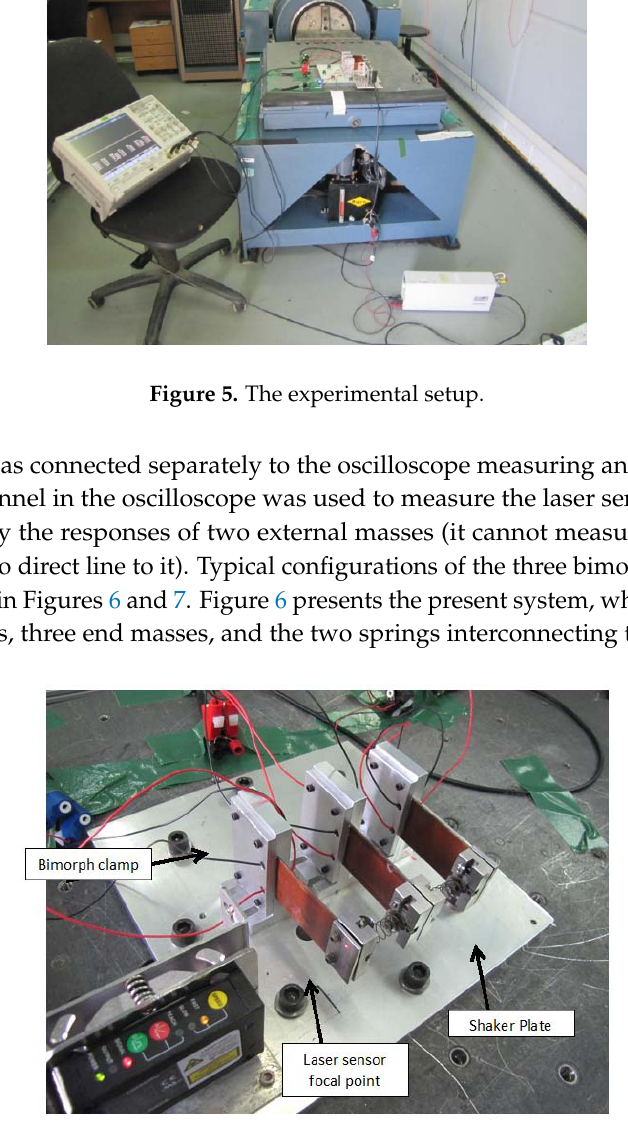
Figure 6. The three bimorphs system the experimental system setup.